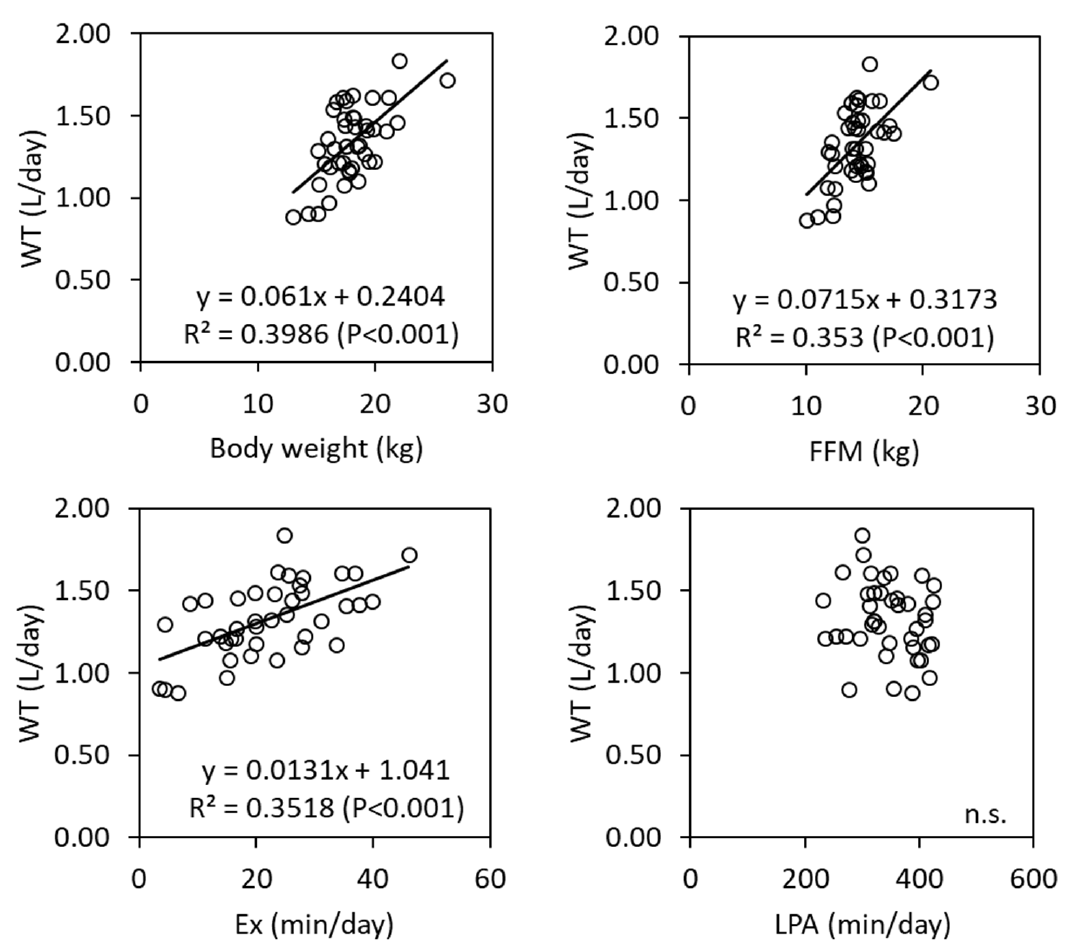
Figure 2. Scatter plots between water turnover (WT) and body weight, fat free mass (FFM), exercise duration (Ex), and light intensity activity (LPA). Table 4. Regression analysis for predicting WT (L/day).